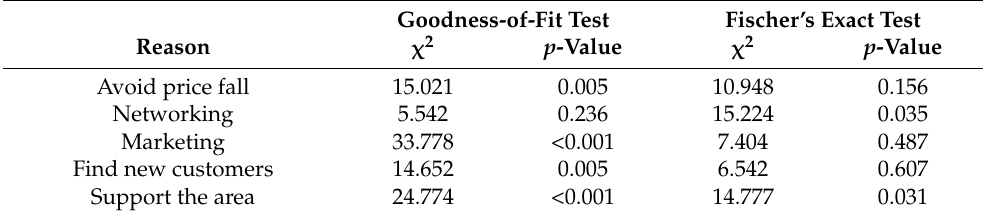
Figure 5. Satisfaction with the effectiveness of the initiative; N = 69. Table 3. Satisfaction with the effectiveness of the system. Goodness of fit test: Comparison of grouped responses from all respondents with expected uniform distributions of responses. Fischer’s exact test: Associations between organizations’ categories and reasons’ ratings. Significance set at a level of 0.05.